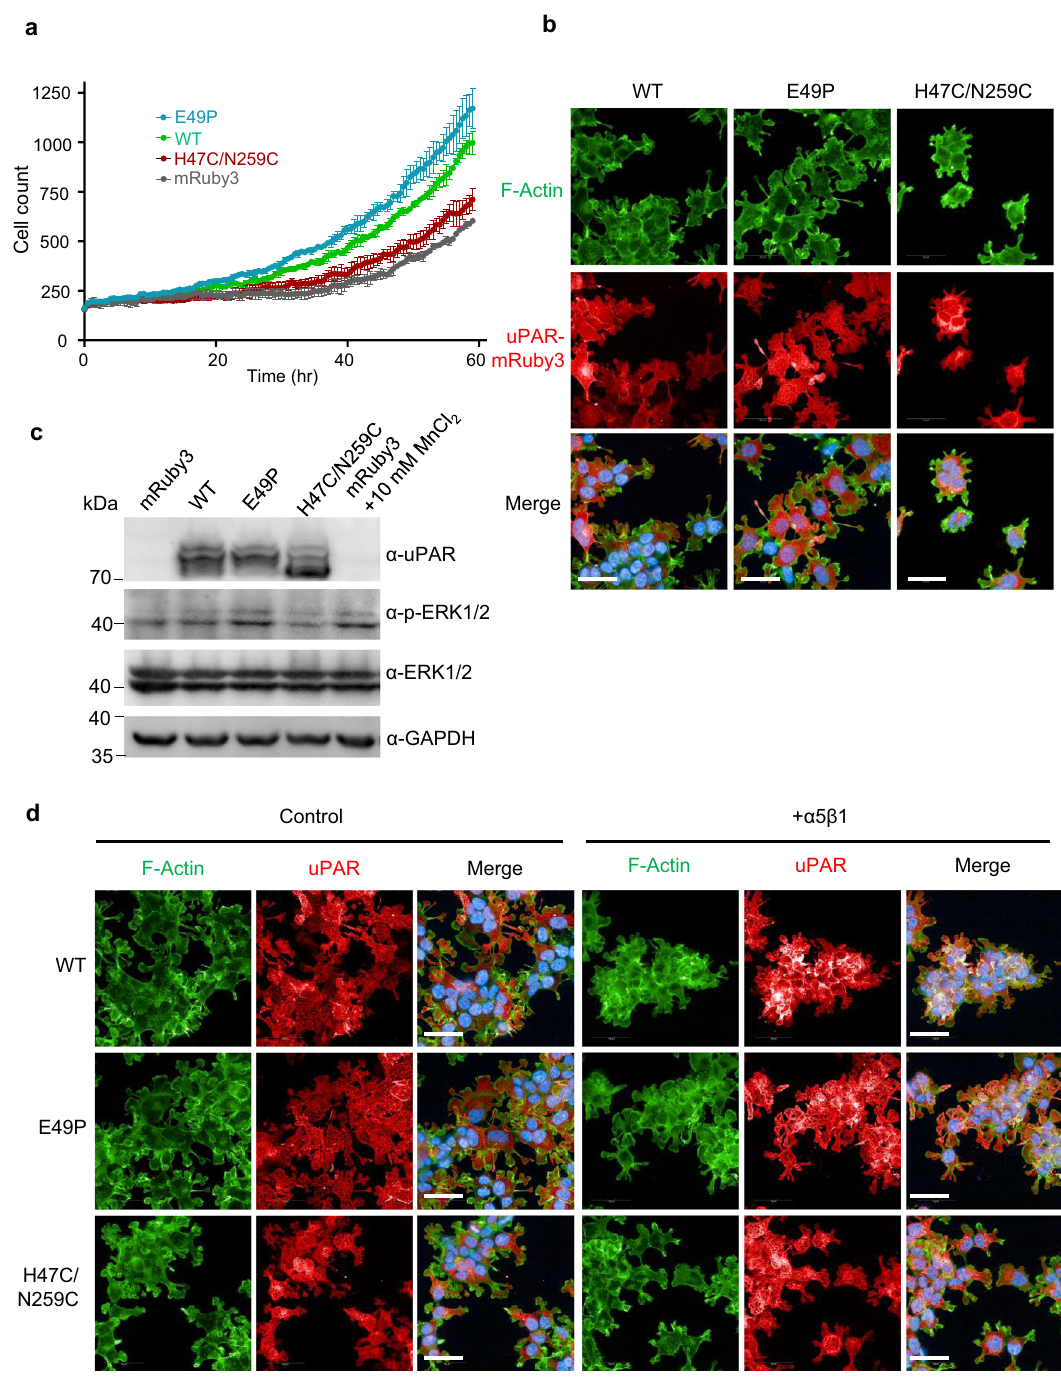
Fig. 5 uPAR dimer had a stronger impact than monomer on cell proliferation and cell morphology. a Cell proliferation curve was generated by analyzing images of DPC (digital phase contrast) for different cell lines as indicated using Operetta CLS software. The DPC channel was recorded every half an hour for 60 h on HCS in the cell culture condition (37 °C, 5%CO 2 ). Data are presented as mean ± SD. Source data are provided as a Source Data fi le. b Microscopic images of the cytoskeleton (green) of uPAR mutants fused with mRuby3 (red) stable cell lines. The cells were treated with Hoechst (blue) for 10 min before fi xation and incubated with Actin-Tracker (green) for 1 h after 10-min permeabilization with 1% Triton X-100. Scale bars, 50 µ m. c Immuno-analysis of mRuby3-tagged uPAR mutants stably expressed in 293T cells. The mRuby3 293T cells were treated with 10 mM MnCl 2 for 30 min as a positive control. Cell lysates were separated and analyzed by immunoblotting using polyclonal anti-uPAR antibody ( α -uPAR), anti-ERK1/2 ( α -ERK1/2), anti-phospho-ERK1/2 ( α -p-ERK1/2), and anti-GAPDH ( α -GAPDH). Source data are provided as a Source Data fi le. d Microscopic images of the cytoskeleton (green) of uPAR mutants fused with mRuby3 (red) stable cell lines treated with integrin for 3 h, then stained as b . Scale bars, 50 µ